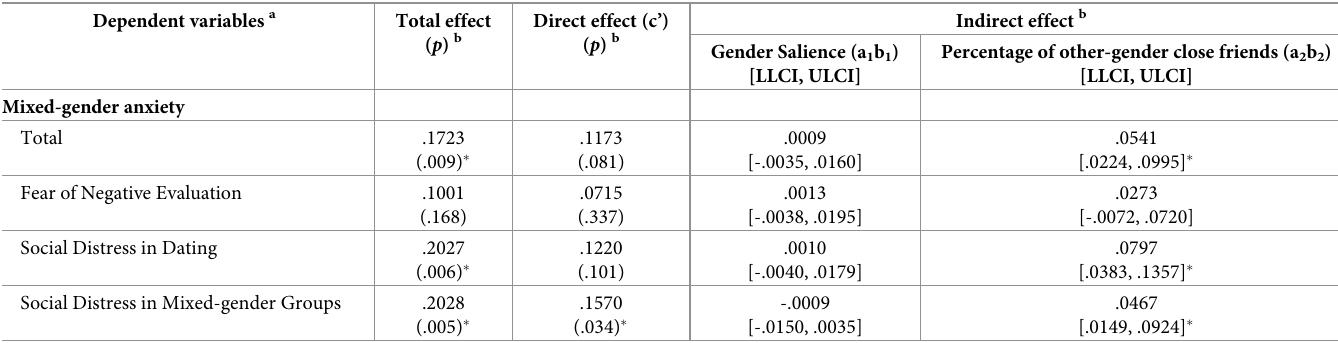
Table 9. Mediation results (Study 2: College